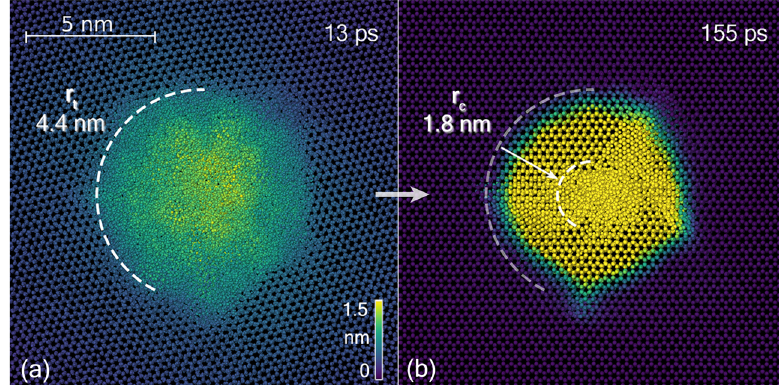
Fig. 1 Simulated 185 MeV Au ion track cross-sections in the deeper regions at different stages. a It shows the moment when the melted zone radius reaches its maximum value. b It shows the fi nal state of the track, demonstrating the partial recrystallisation of the initial melted volume. The colour scheme represents the magnitude of the displacement of the atoms from their original positions. Refer to Supplementary Movie 1 to visualise the entire recrystallisation